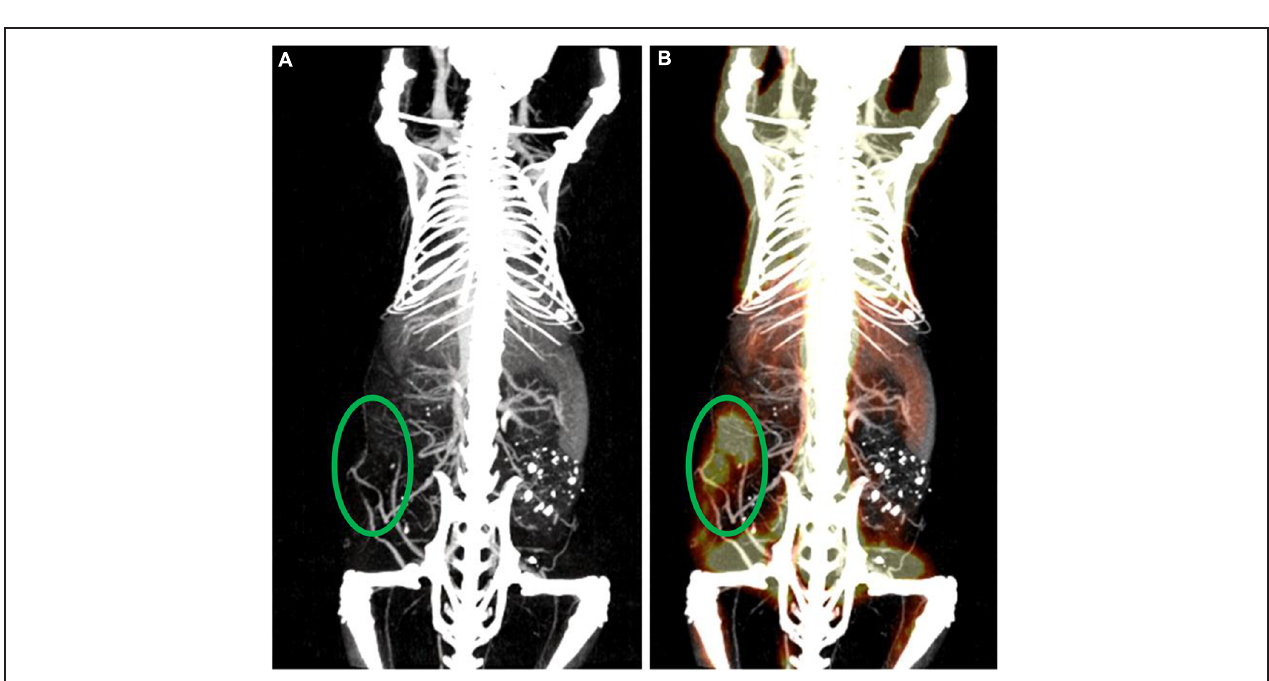
FIGURE 11 | Multi-modal micro-CT/micro-PET imaging. (A) Maximum intensity projection rendered micro-CT image acquired 1 h post-administration of PEGylated liposomal-iodixanol. (B) The overlaid PET/CT image shows the metabolically active tumor (green ellipse).